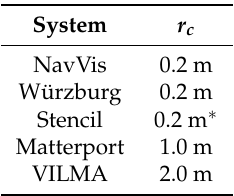
Table 3. Magnitude of r c on which the saturation of total error E is reached without outliers or completeness issues. Best result first. ∗ See the